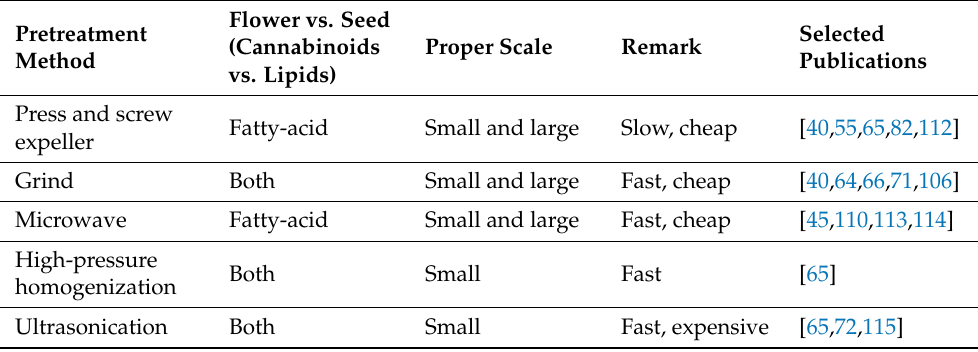
Table 7. Classification of pretreatment